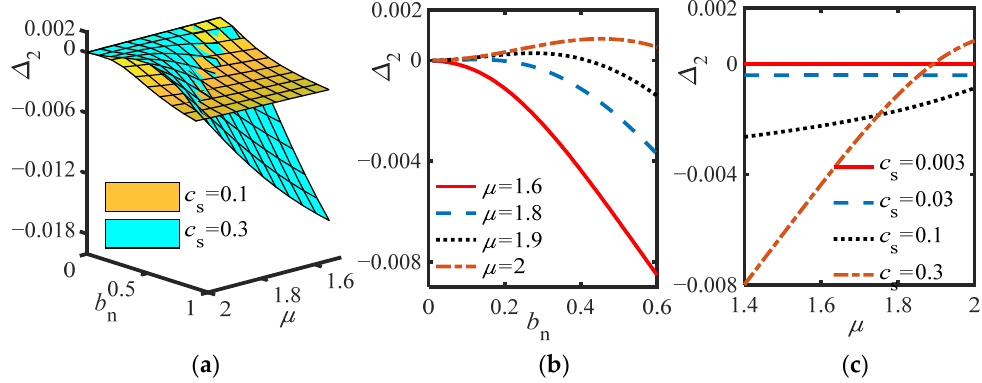
Figure 6. ( a ) Δ 2 vs. μ and b n for different c s; ( b ) Δ 2 vs. b n for different μ ( c s = 0.3); ( c ) Δ 2 vs. b n for Figure 6. ( a ) ∆ 2 vs. µ and b n for different c s; ( b ) ∆ 2 vs. b n for different µ ( c s = 0.3); ( c ) ∆ 2 vs. b n for different c s ( m 2 = 0, cn = 0.002, b n = 0.4) . different c s ( m 2 = 0, c n = 0.002, b n =